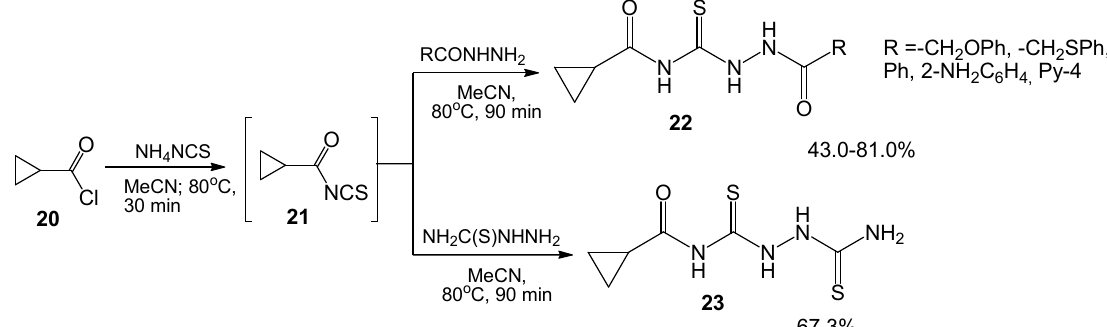
Fig. 5. Synthesis of chiral urea, thiourea and acylthiourea with a fragment of (R)-2-amino-1-butanol